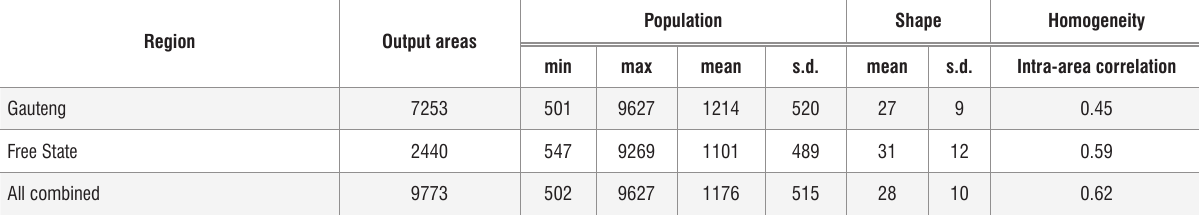
Table 4: Statistical characteristics of Free State and Gauteng Province output areas and the two provinces combined